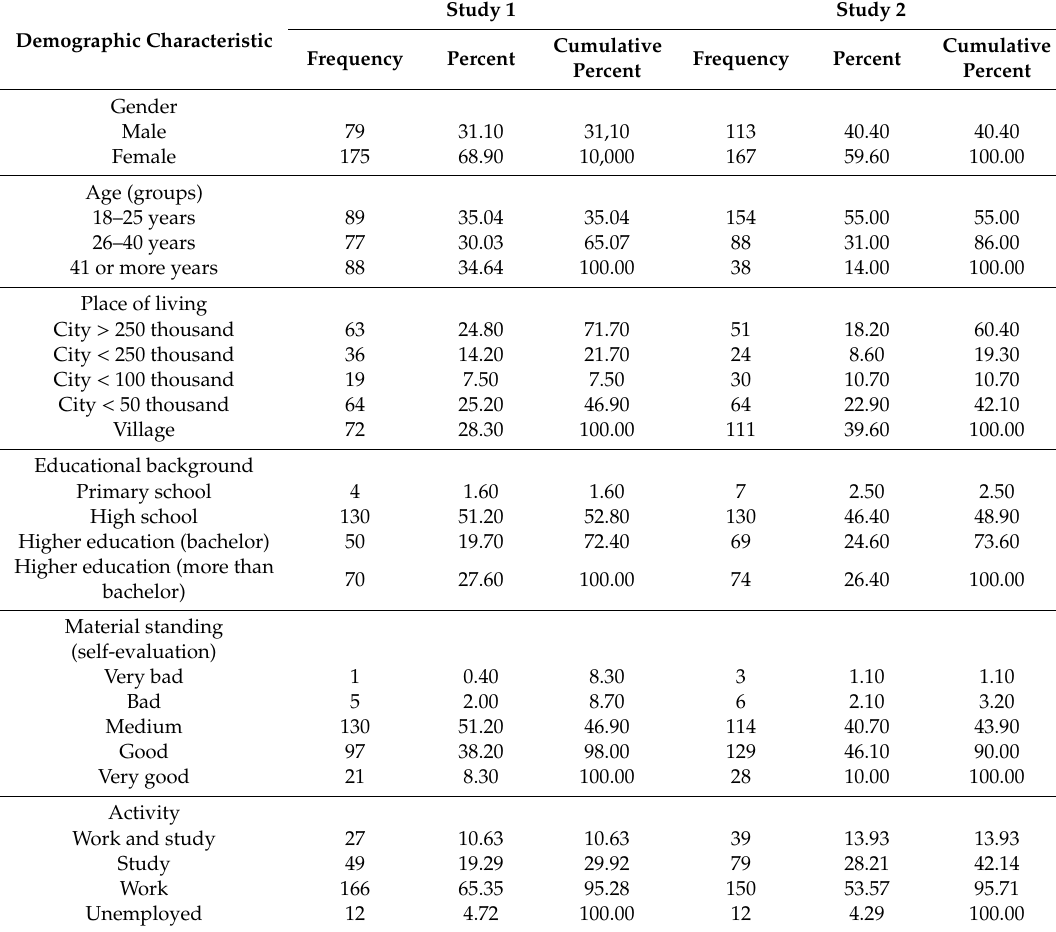
Table 1. Demographic characteristics of two groups of participants (Study 1 and Study